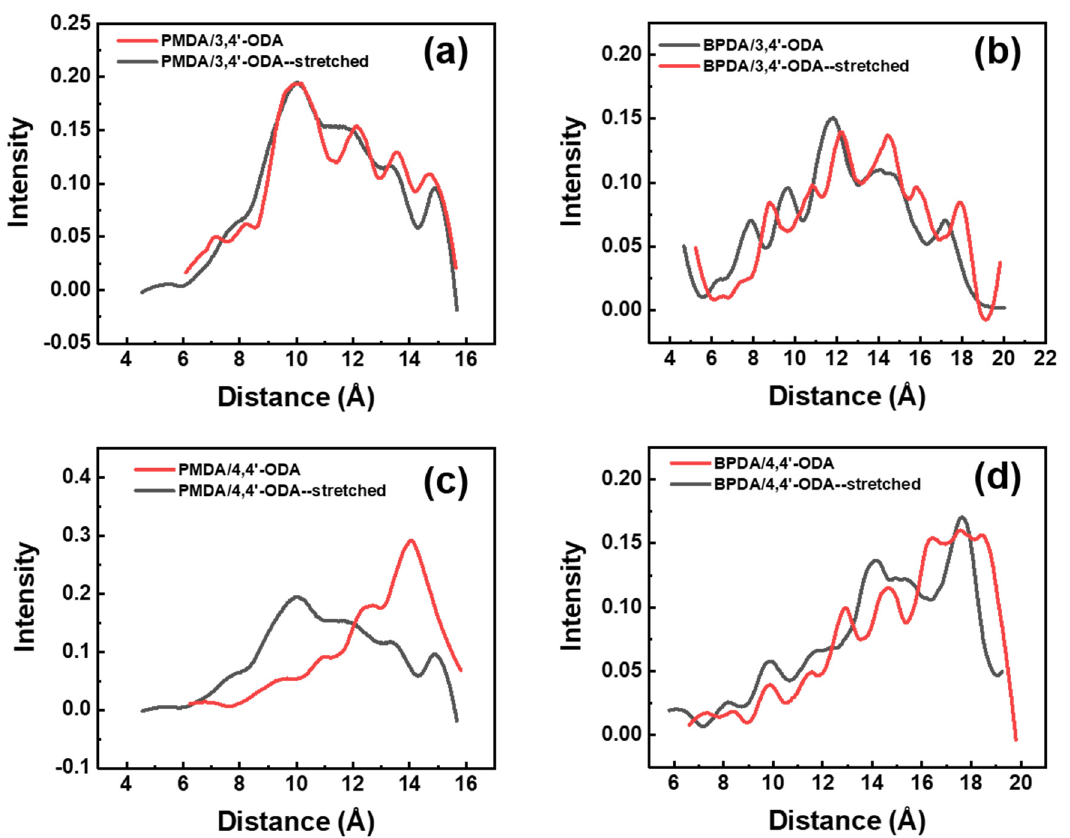
Figure 5. The distribution of a repeat unit length before and after stretching of different systems of PI. ( a ) PMDA/3,4 ′ -ODA; ( b ) BPDA/3,4 ′ -ODA; ( c ) PMDA/4,4 ′ -ODA; ( d ) BPDA/4,4 ′ -ODA.